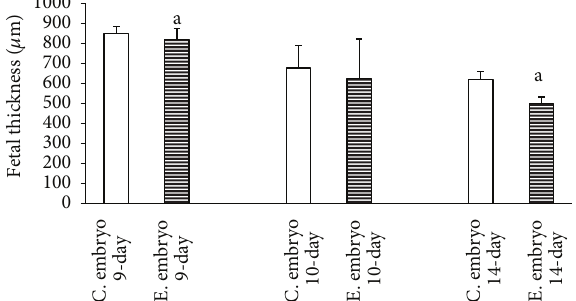
Figure 2: Reviewing the graph illustrating the time-dependent effect of oral morphine consumption on the development of the thickness of the fetal portion of the placenta for three different periods of pregnancy (9-day, 10-day, and 14-day pregnant mothers), and a comparison between the experimental (E) groups and the control (C) groups reveals the reduction of the fetal portion of the placenta in the experimental group, compared to that of the control groups ((a) 𝑃 value of < 0.01 indicating a significant difference).